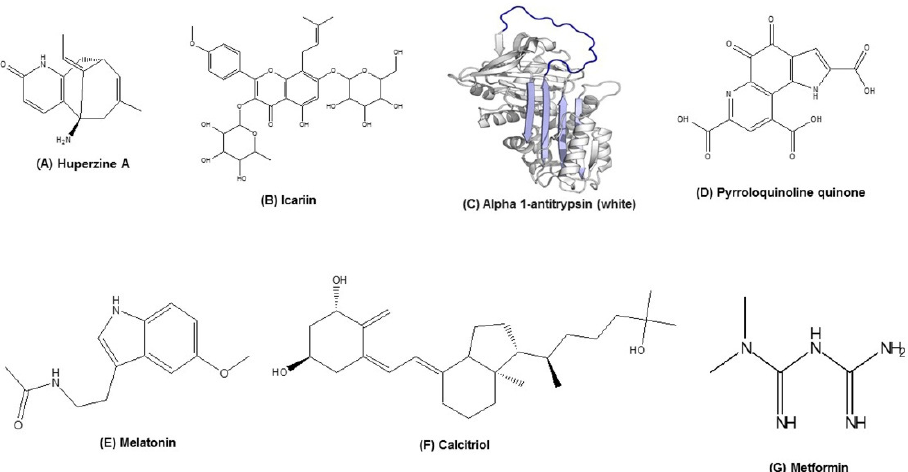
Figure 2. Chemical structures of selected natural and synthetic nutrient compounds targeting in-